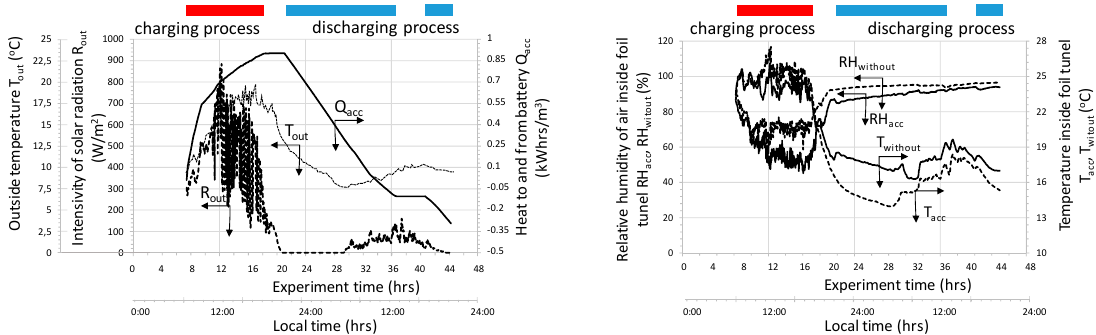
Figure 10. The course of measured and calculated parameters during the full cycle of charging and discharging a stone-bed accumulator.